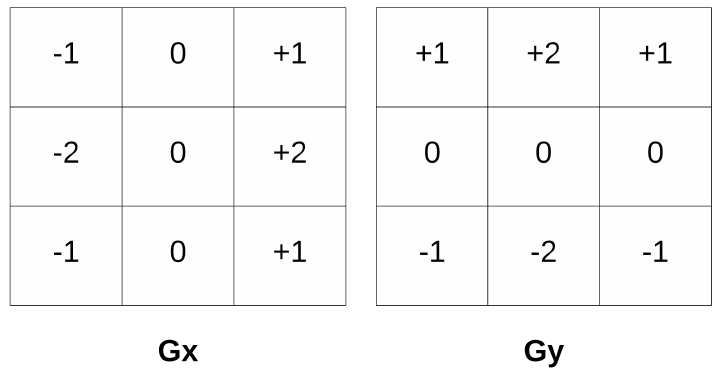
Figure 2. Sobel gradient